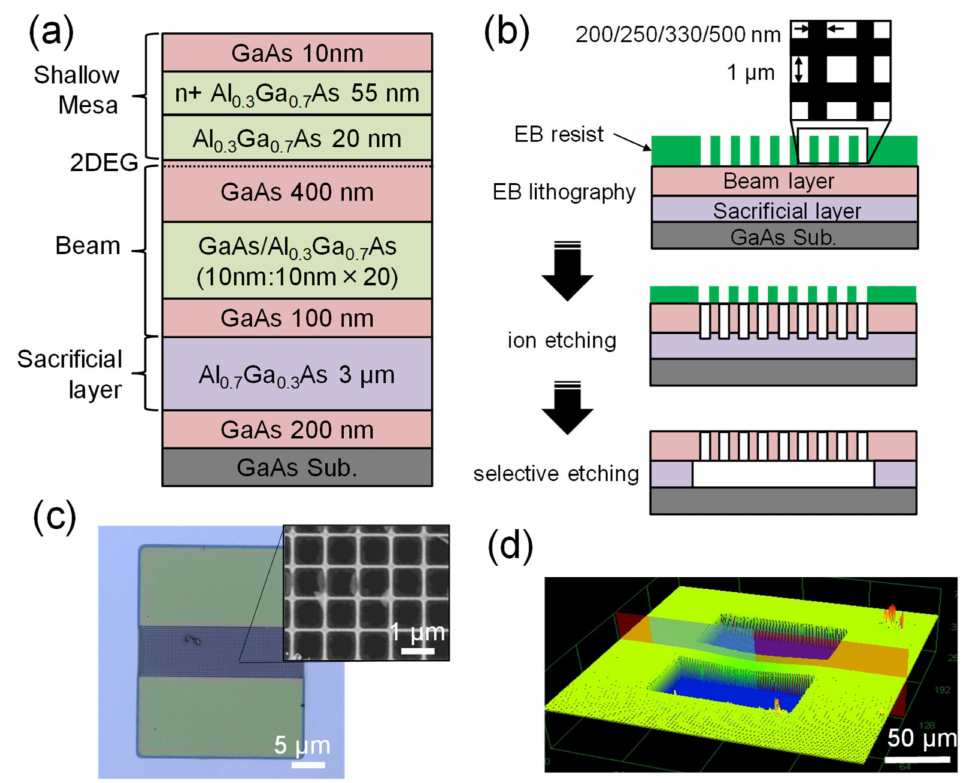
Figure 2. ( a ) The schematic wafer structure for the fabrication of the porous MEMS beams. ( b ) Fabrication of the MEMS beams with porous nanomesh structures. The size of the square hole was fixed at 1 µ m × 1 µ m, and the linewidth of the mesh was modulated from 200 nm to 500 nm, yielding a range of P from ~0.44 to ~0.69. ( c ) A microscope image of a fabricated MEMS beam with a porous nanomesh structure ( P = 0.69). The inset shows a blown-up image taken by a scanning electron microscope to demonstrate details of the nanomesh structure. ( d ) The surface profile of the MEMS beam measured with a confocal laser microscope. The center of the beam is bent downward by ~400